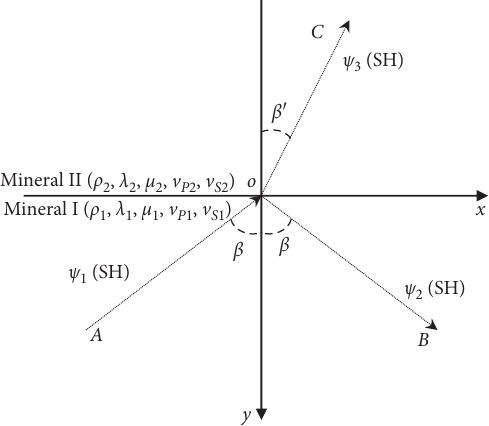
Figure 8: Propagation of AE S-wave on mineral